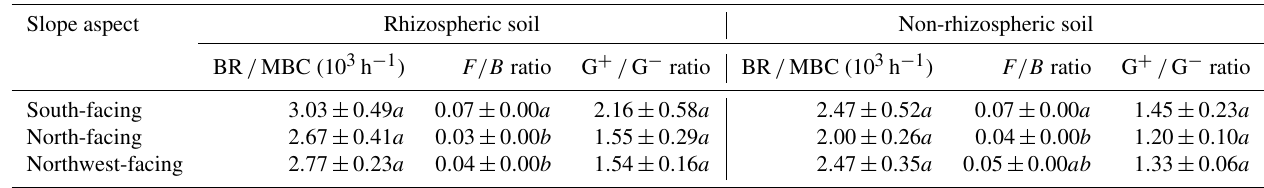
Table 4. Microbial respiratory quotients (BR / MBC), ratios of fungal PLFA content to bacteria PLFA content ( F/B ), and ratios of G + PLFA content to G − PLFA content (G + / G − ) in the rhizospheric and non-rhizospheric soils. Values are means ± standard errors ( n = 3). Slope aspect Rhizospheric soil Non-rhizospheric soil BR / MBC (10 3 h − 1 ) F/B ratio G + / G − ratio BR / MBC (10 3 h − 1 ) F/B ratio G + / G − ratio South-facing 3 . 03 ± 0 . 49 a North-facing Northwest-facing 2 . 77 ± 0 . 23